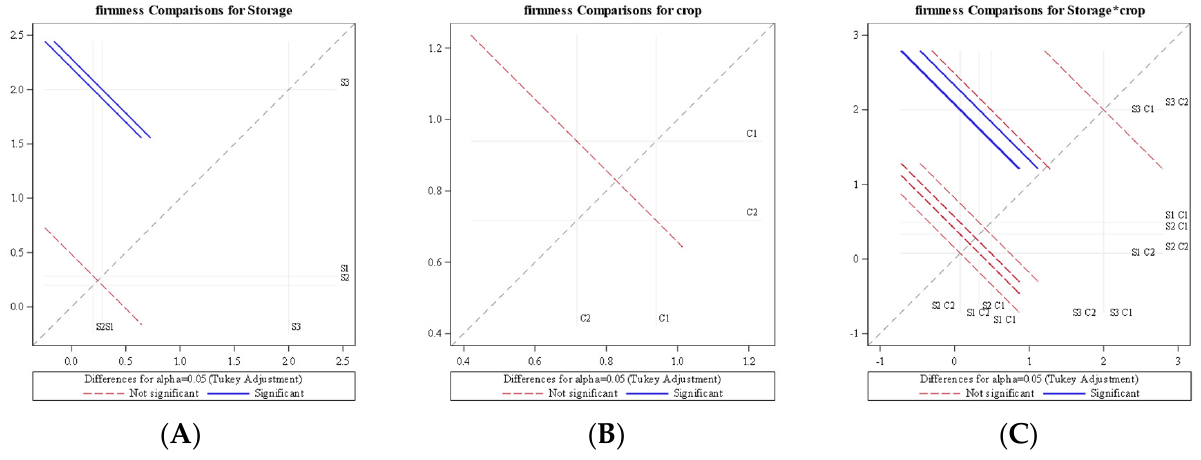
Figure 5. Diffogram showing the effect of storage condition and crop on average daily firmness reduction. ( A ) Firmness comparison for storage ( B ) Firmness comparison for crop ( C ) Firmness comparison for storage*crop S1—LCTR; S2—VCR; S3—ambient storage; C1—bitter gourd;